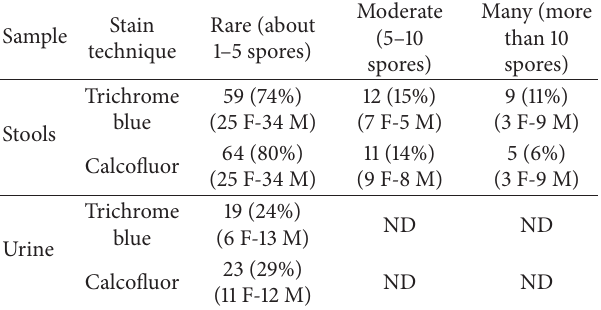
Table 2: Number of rabbits showing the number of spores found in stools or